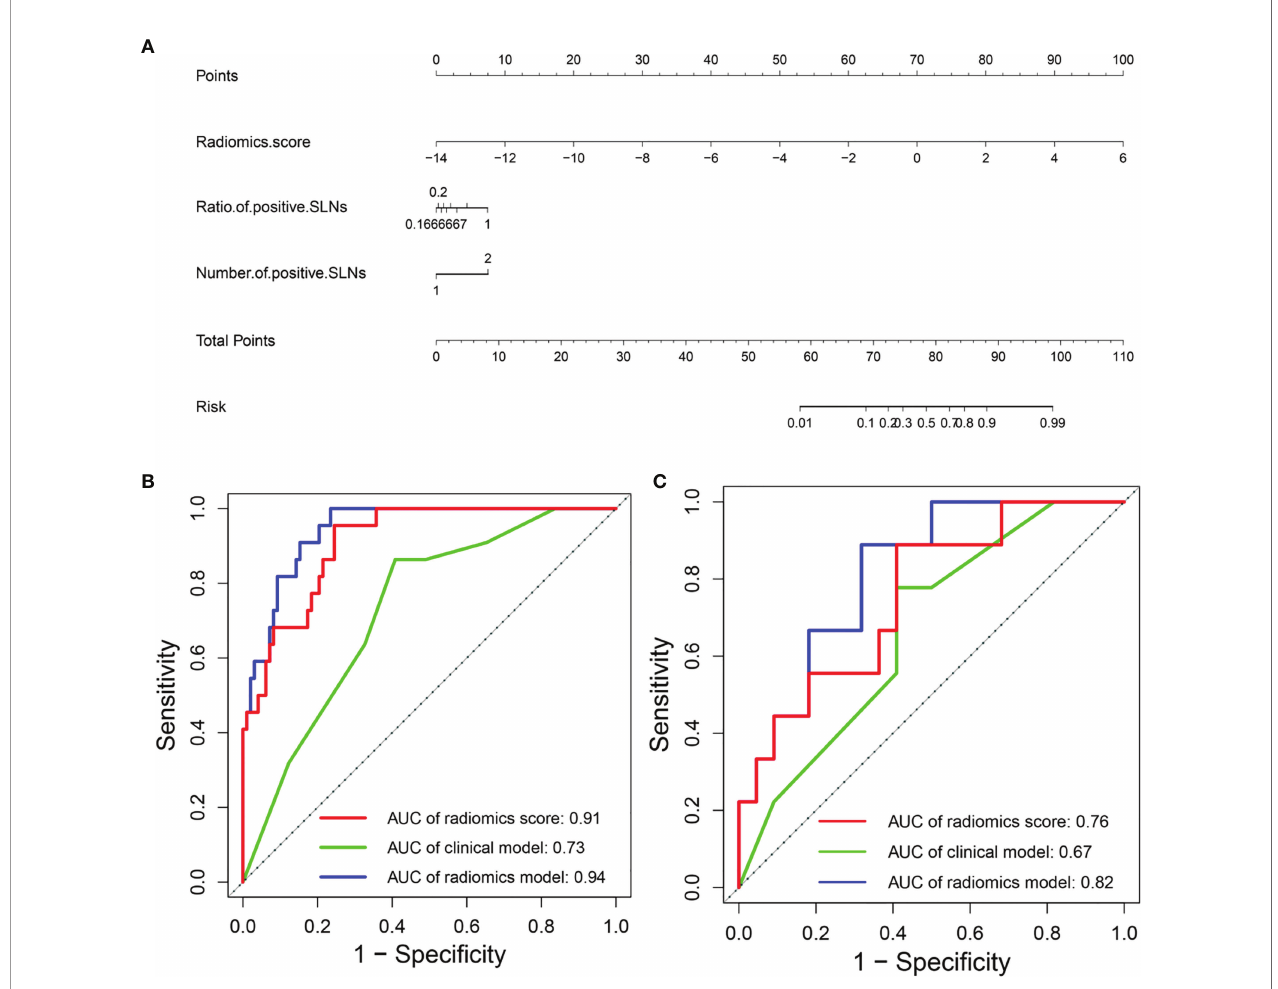
FIGURE 8 | (A) Radiomics nomogram to predict the probability of high axillary tumor burden. ROC curves of the clinical model and radiomics model in the (B) training and (C) testing sets. ROC, receiver operating